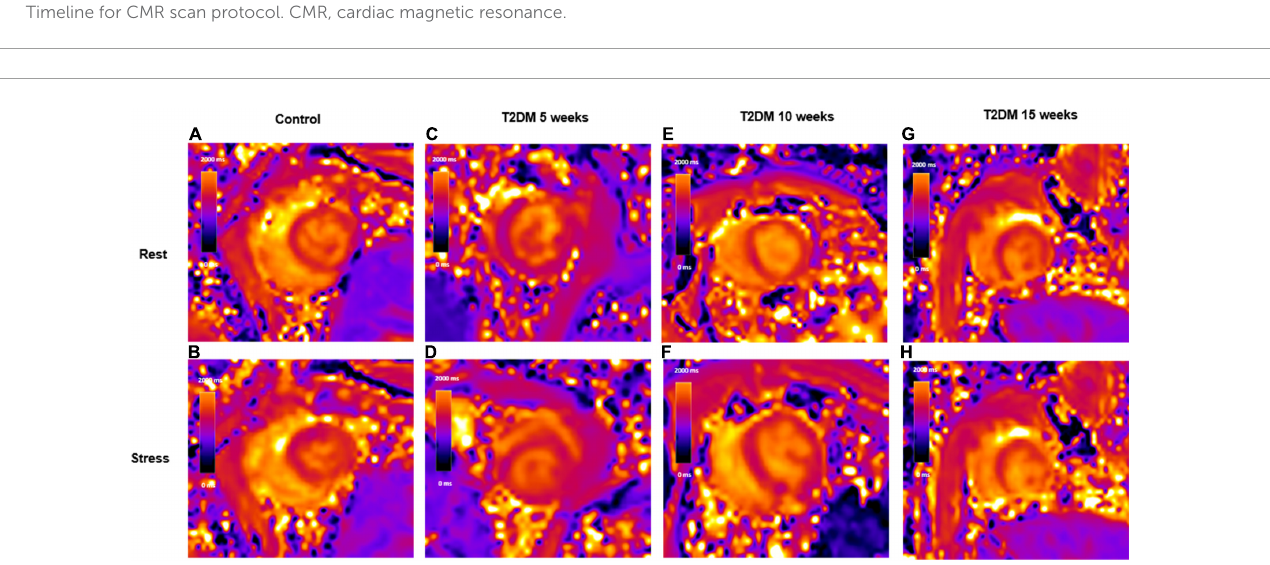
FIGURE2 Schematic representation of rest and stress T1 maps. A control rabbit with a resting T1 map, 1,355 ms (A) and corresponding stress T1 map, 1,445 ms (B) ; A 5-week T2DM rabbit with a resting T1 map, 1,321 ms (C) and corresponding stress T1 map, 1,379 ms (D) ; A 10-week T2DM rabbit with a resting T1 map, 1,378 ms (E) and corresponding stress T1 map, 1,426 ms (F) ; A 15-week T2DM rabbit with a resting T1 map, 1,429 ms (G) and corresponding stress T1 map, 1,469 ms (H) . Values in the graphs indicate the median T1 values of myocardial interventricular septum. T2DM, type 2 diabetes mellitus.